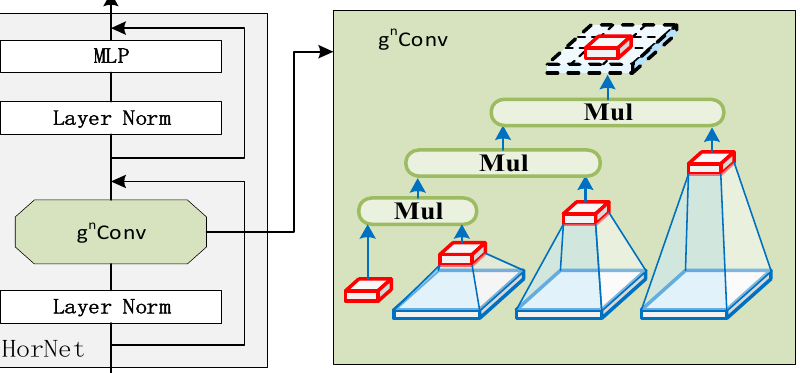
Figure 1. Network architecture of HorNet.